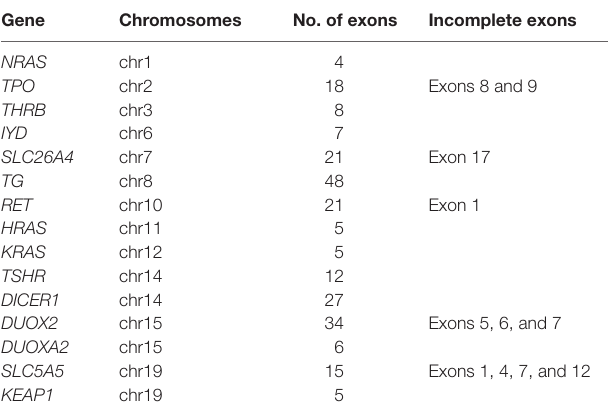
taBLe 1 | Genes and exons included in Goiter ampliseq panel.